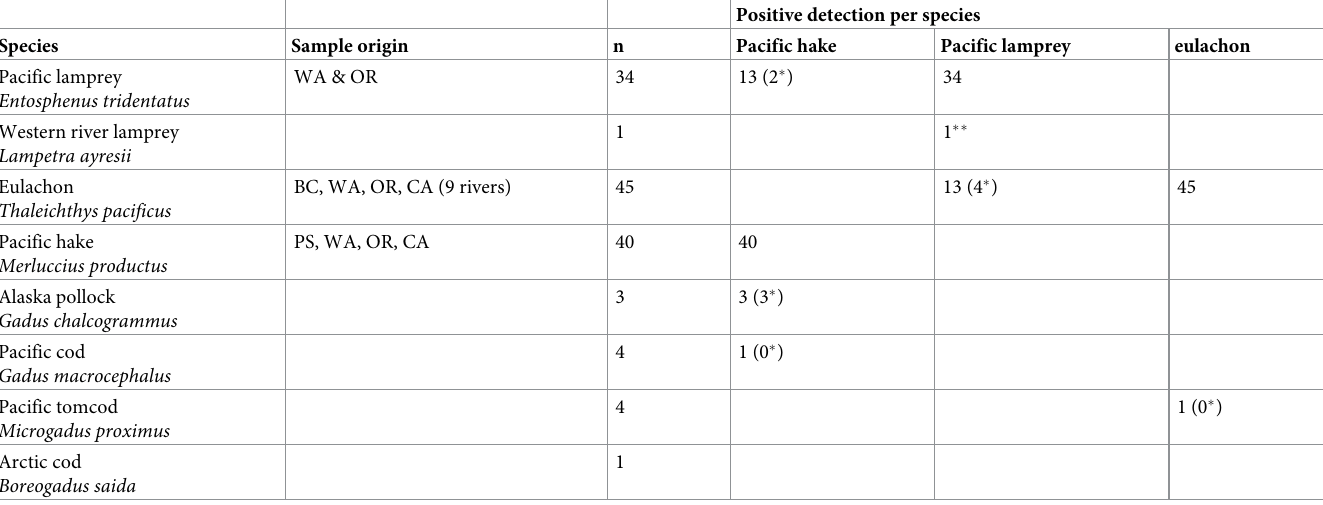
Table 3. List of species used for the specificity and reproducibility tests and number of positive results in the multiplex